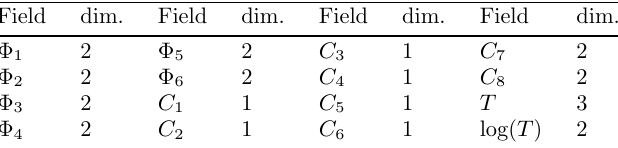
Fig. 1. The geometry and flow field used for the snapshot gener- ation with the FOM. Dimensions are shown in mm. (P – Pump, HX – Heat Exchanger).